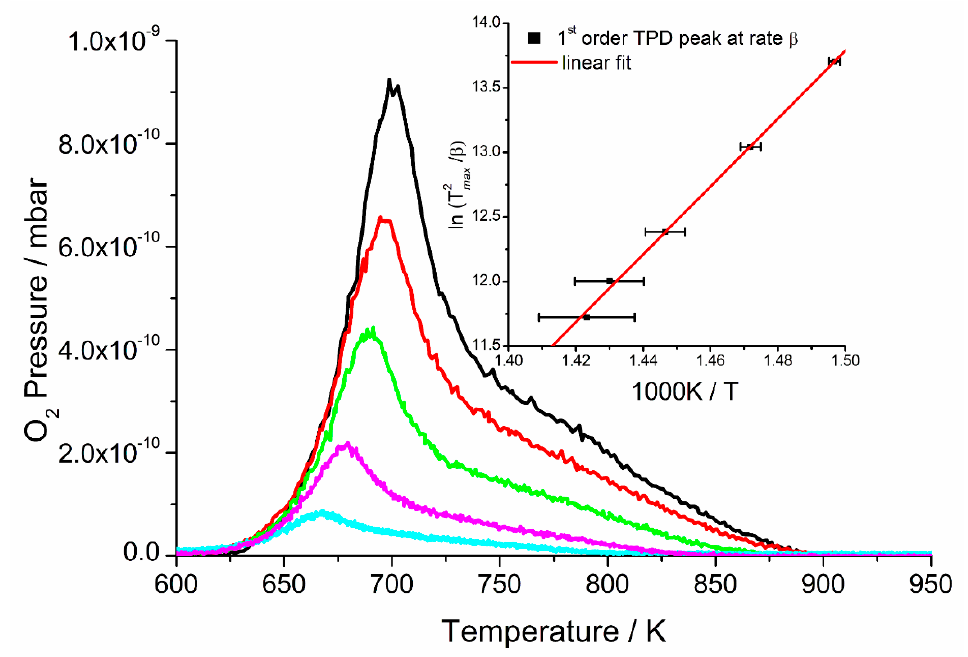
Figure 4. TPD spectra of oxygen for heating rates of 0.5, 1, 2, 3 and 4 K/s in the order of increasing peak maximum. The clean Pt{110} sample was dosed with 22.5 L of oxygen at 420 K with TPD recorded angle integrated from the main chamber MS. The insert shows a plot of the peak maximum points linearised according to Equation (1).